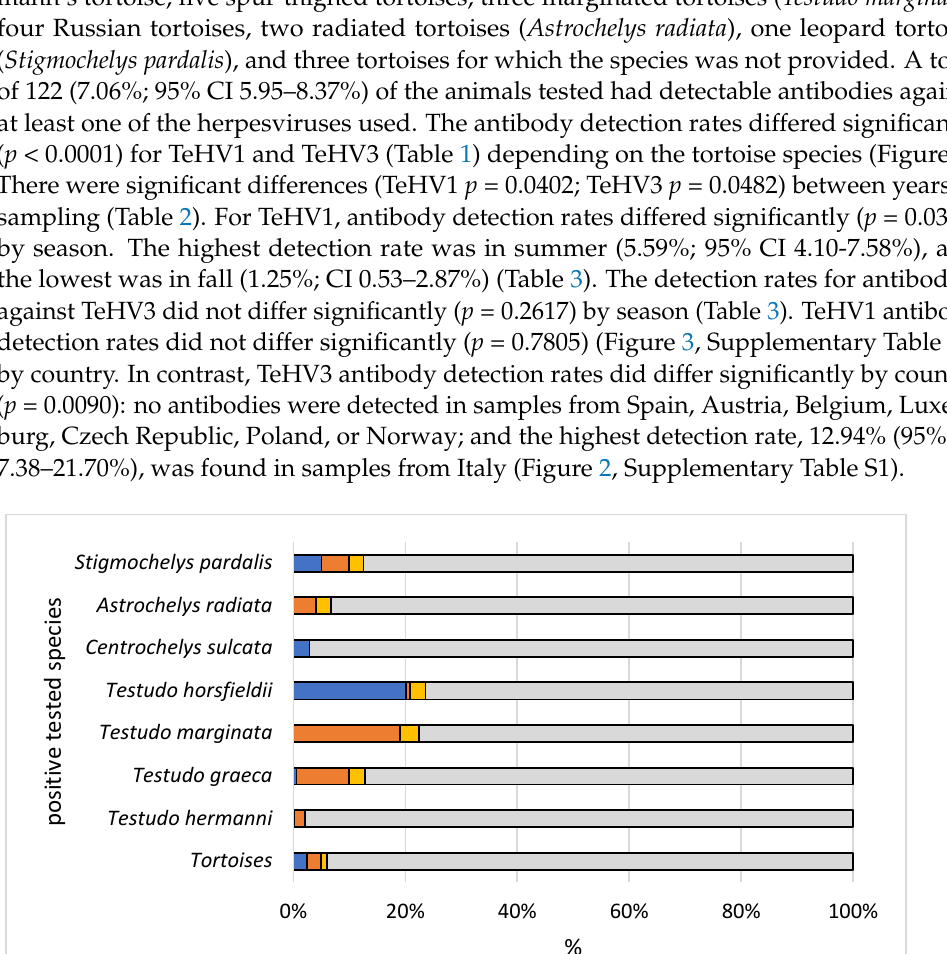
Figure 2. Herpesvirus (TeHV1) antibody detection rates (titer 2 or higher) divided into the countries of origin with more than 20 tested samples. Countries with lower numbers of samples submitted are shown in grey.